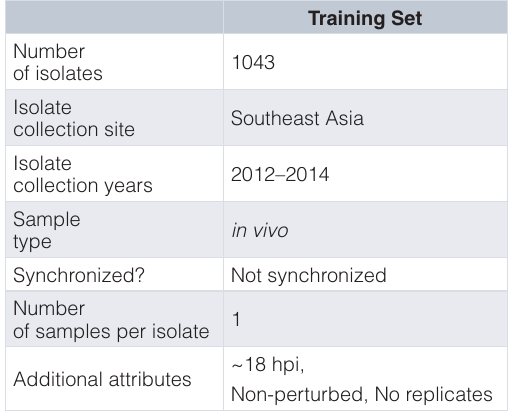
Table 8. Training dataset information from Mok et al. , 2015 28